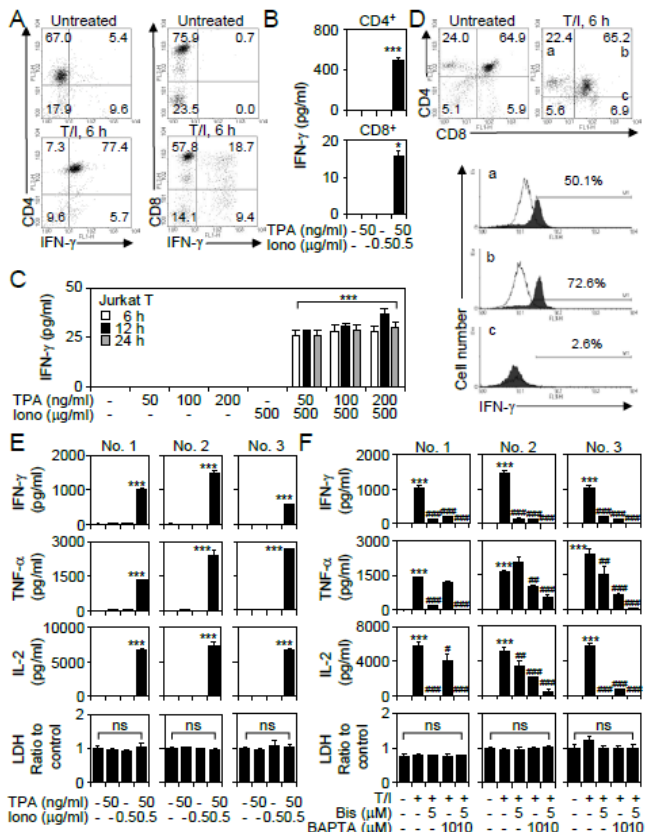
Figure 1. A combination of 12-O-tetradecanoylphorbol-13-acetate (TPA) and ionomycin causes in vitro activation of CD4 + T lymphocytes. ( A ) Representative dot plots of immunostaining followed by flow cytometric analysis detected the IFN- γ expression in CD4 + and CD8 + T lymphocytes 6 h posttreatment with TPA plus ionomycin (T / I). In addition, ELISA determined the levels of IFN- γ in the cell supernatants of TPA-, ionomycin (Iono)-, and T / I-treated CD4 + and CD8 + T lymphocytes ( B ) and Jurkat T cells ( C ). ( D ) Representative dot plots and histograms of immunostaining followed by flow cytometric analysis detected the IFN- γ expression in T / I-stimulated murine CD4 + CD8 − (a), CD4 + CD8 + (b), and CD4 − CD8 + (c) thymocytes. Primary CD4 + T cells were obtained from three individual volunteers of number (No.) 1 to 3. ELISA determined the levels of cytokines in the cell supernatants of TPA-, ionomycin-, or T / I-treated CD4 + T cells 6 h posttreatment ( E ) without or ( F ) with Bis (5 µ M) and BAPTA (10 µ M) pretreatment for 0.5 h. An LDH assay was used to detect cell cytotoxicity, and the results are normalized to the untreated group. For flow cytometric analysis, the percentages of IFN- γ -expressing cells are shown. For ELISA, the data are shown as the mean ± SD from three individual experiments. * p < 0.05 and *** p < 0.001 compared to untreated cells. # p < 0.05, ## p < 0.01, and ### p < 0.001 compared to the T / I-treated group. ns, not